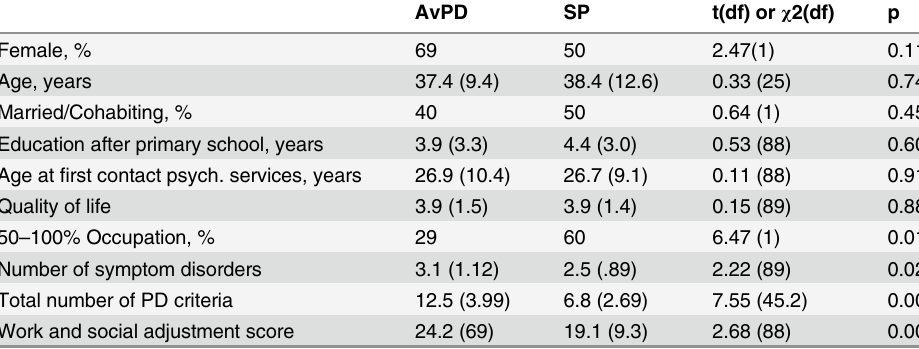
Table 2. Socio-demographic and clinical characteristics of patients with AvPD a (n = 71) and SP b (n =